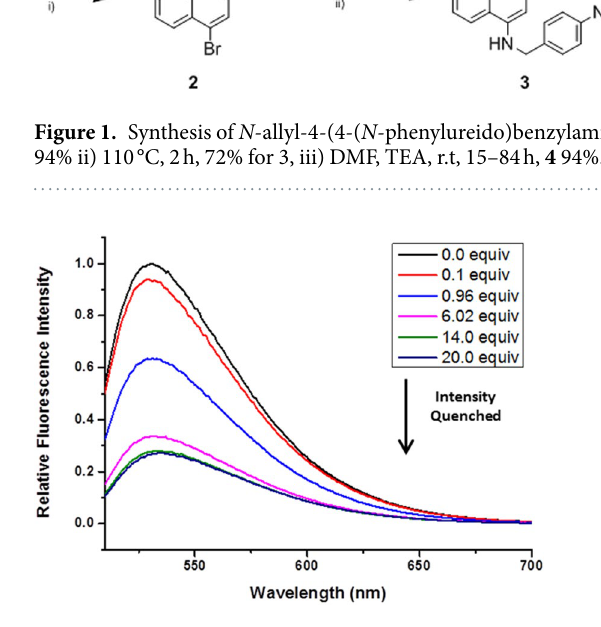
Figure 2. Fluorescence spectra of 4 with increasing equivalents of tetrabutylammonium acetate in hydrated (0.5% v/v) DMSO, λ ex = 503.93